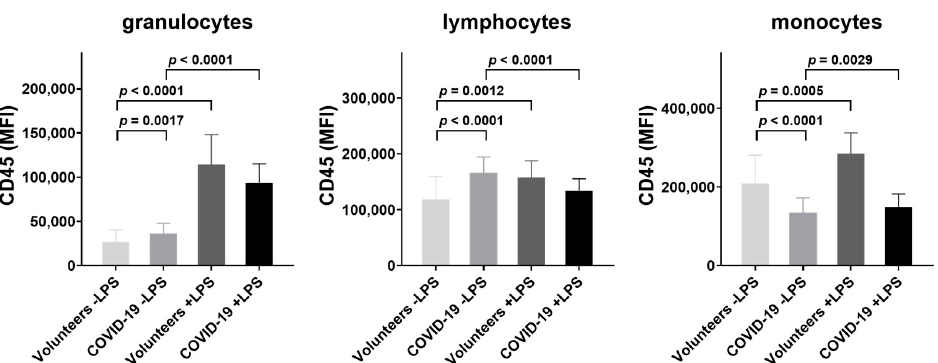
Figure 3. Surface expression of CD45 on granulocytes, lymphocytes, and monocytes in healthy volunteers ( n = 20) and patients with COVID-19 ( n = 112). Whole blood samples were incubated in absence and presence of LPS (100 ng/mL, 60 min), stained with a fluorescent CD45 antibody, and subjected to FACS analysis. Data are given as mean and SEM; Student’s t -test was used for statistical evaluation.